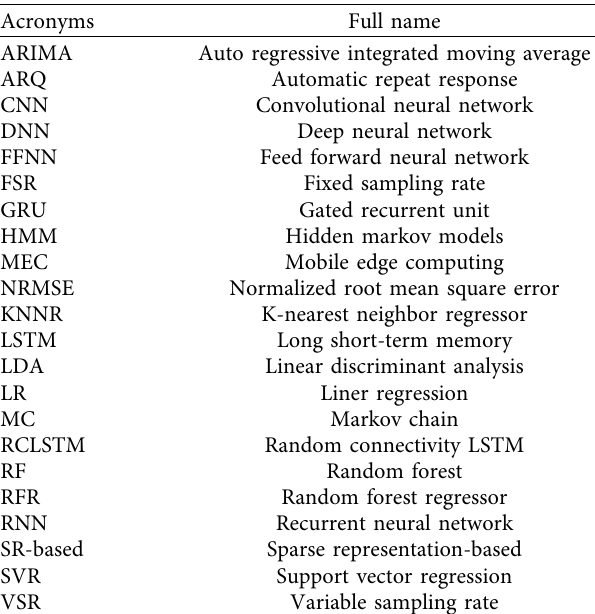
Table 2: Acronyms list in this paper.